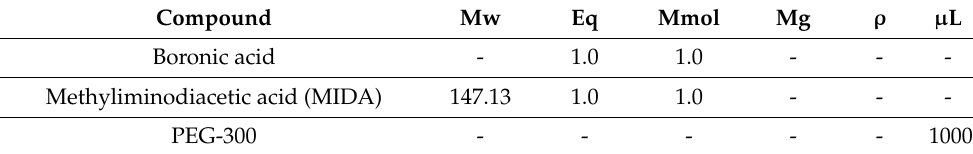
Table 1. PEG-300 Table 1. PEG-300 Procedure. Table 1. PEG-300 Procedure.